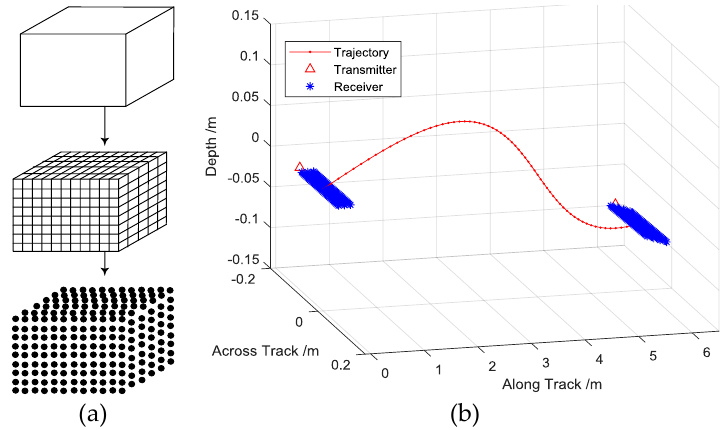
Figure 6. Target segmentation and moving trajectory of carrier: ( a ) highlights segmented on the surface; ( b ) moving trajectory of the carrier.